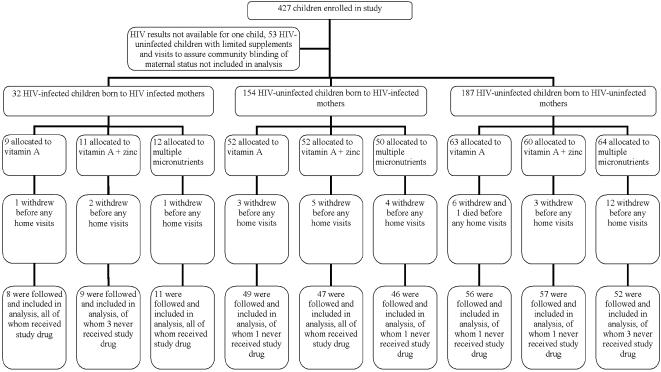
Patient Flowchart